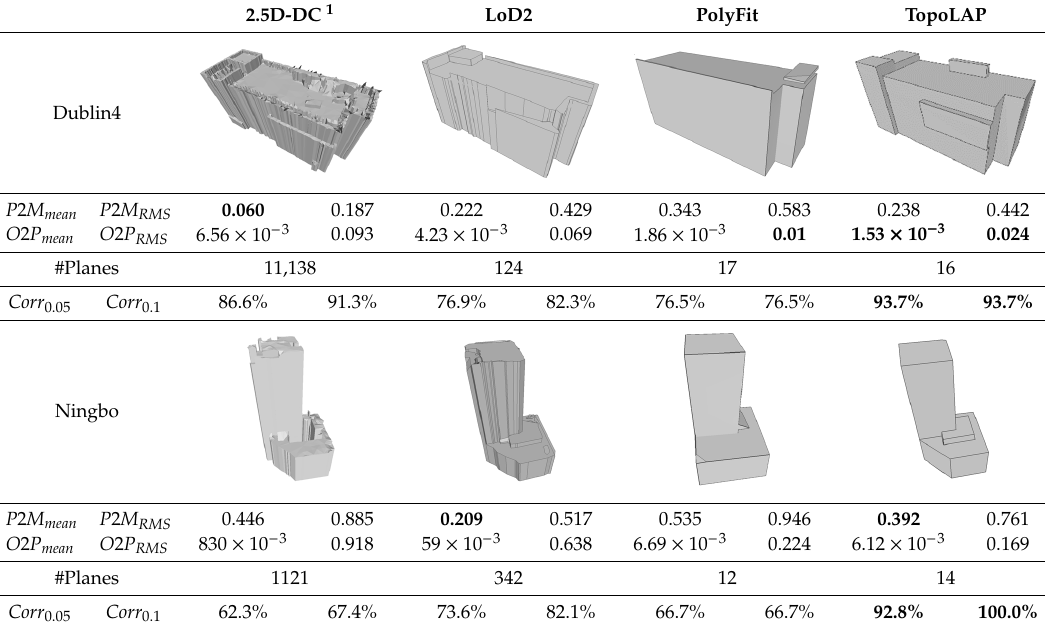
Table 4. Visual and quantitative comparison to the related works.